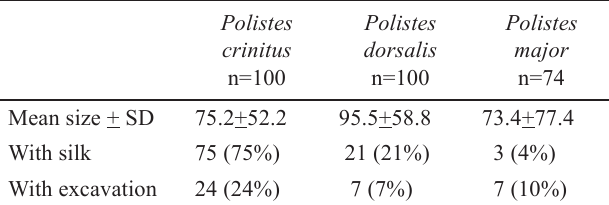
Table 1 . Mean size (number of cells) of old nests, frequency of nests with parasitoid silk, and frequency of nests with evidence of cell excavation in three Jamaican social wasps. Further explanation in text.